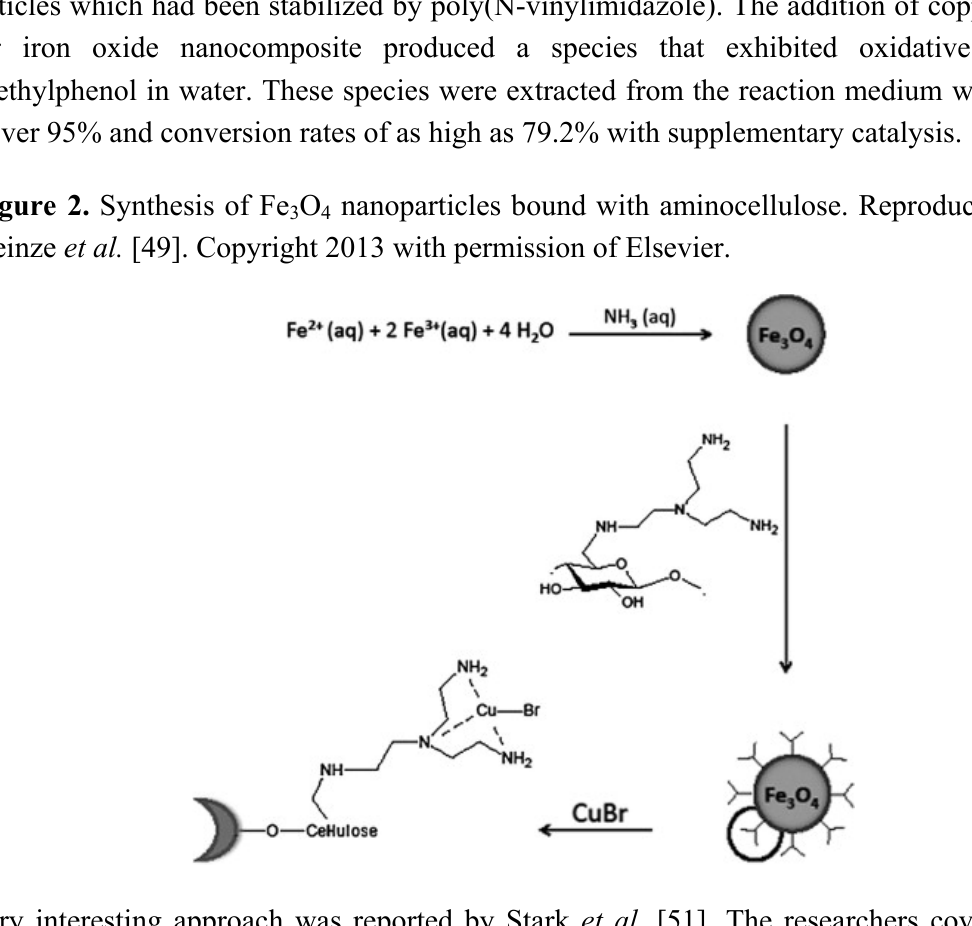
O nanoparticles bound with aminocellulose. Reproduced from 3 4